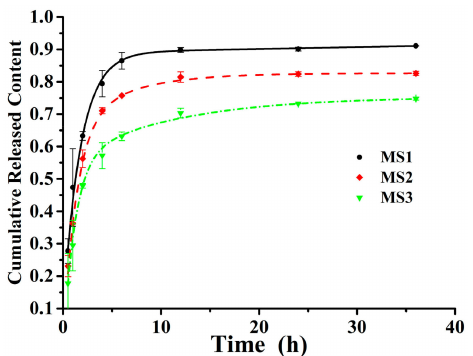
Figure 8. Cumulative release profiles of the azoxystrobin